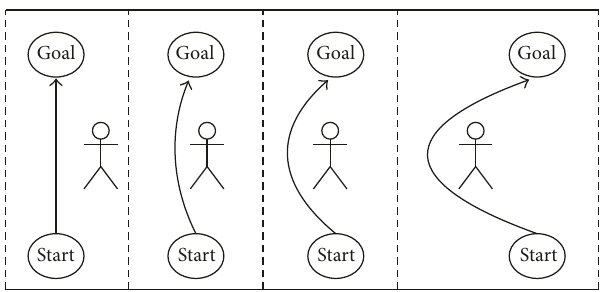
Figure 3: Pedestrian crossing from east to west of the trajectory generated.